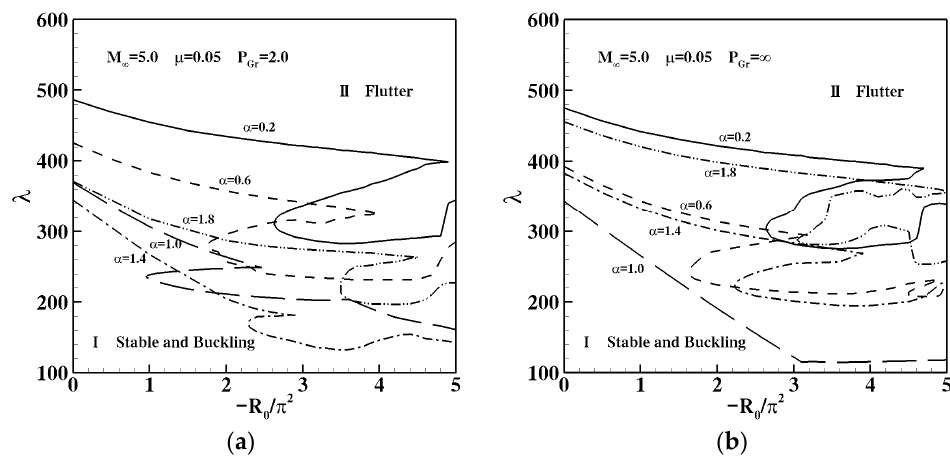
Figure 12. Stability regions under different coefficients of head-panel pressure: ( a ) P Gr = 2.0; ( b ) P Gr = ∞